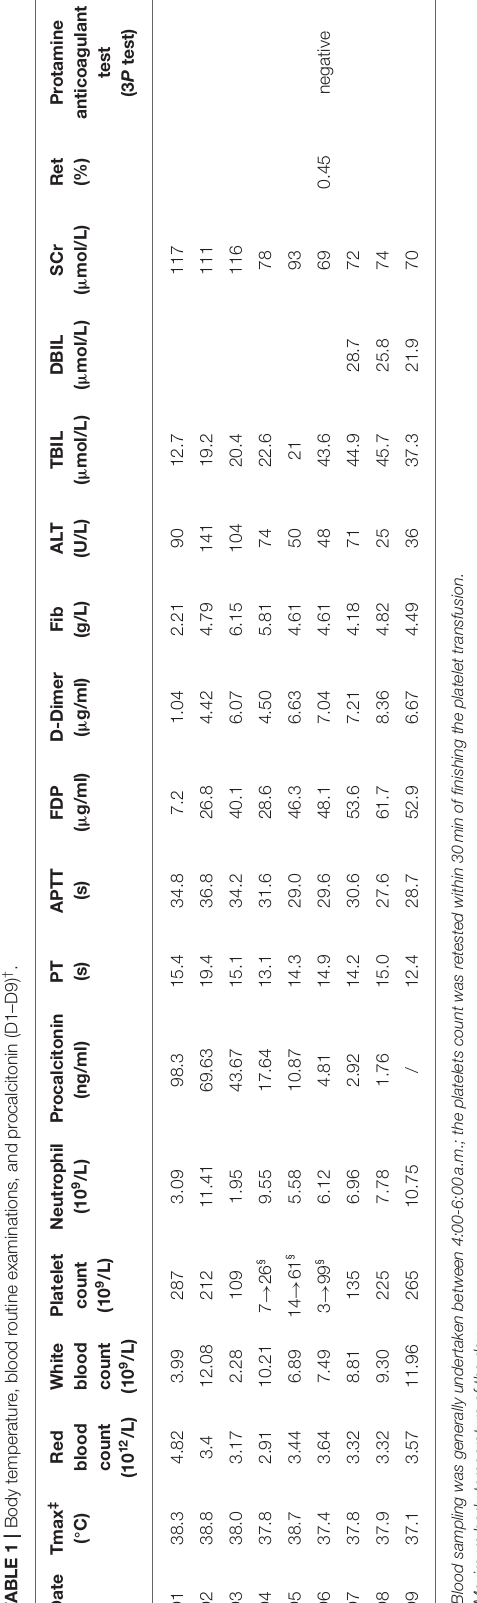
markers. For instance, myelodysplastic syndrome or